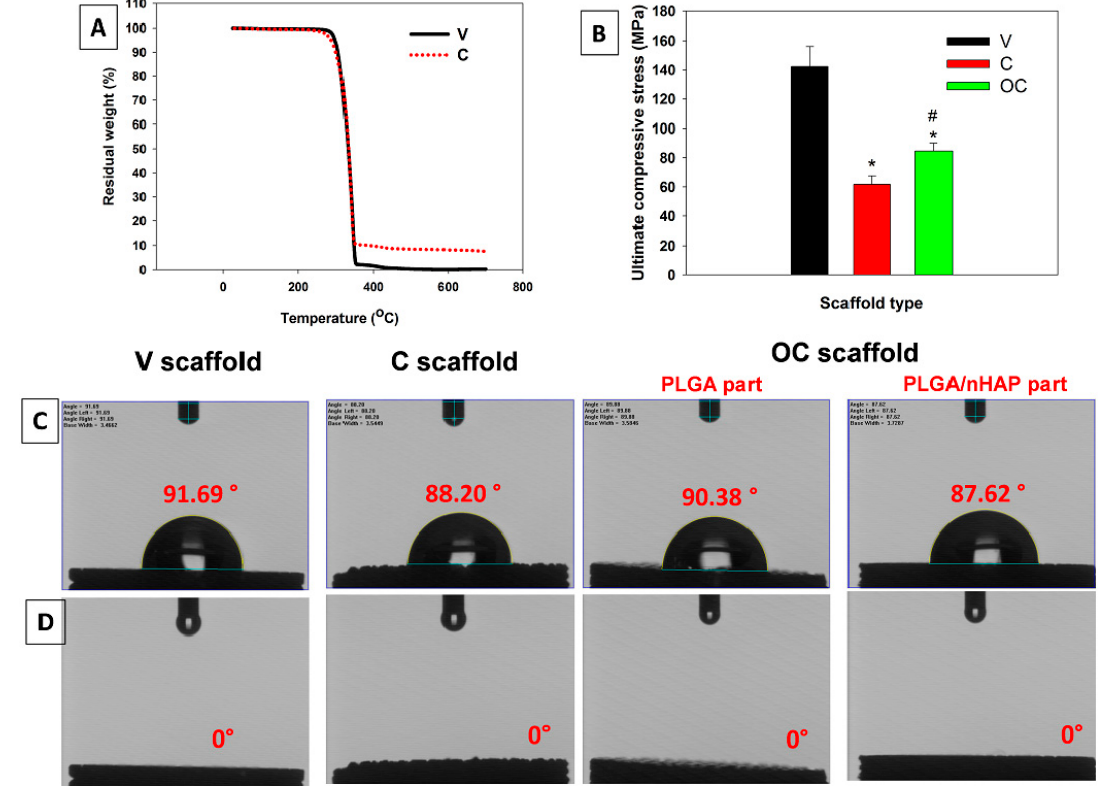
Figure 3. Thermal decomposition behavior ( A ) and mechanical testing ( B ) of V and C, and OC scaffolds. Surface hydrophilicity of V, C, and OC scaffolds by measuring water contact angles after 2 s ( C ) and 30 s ( D ); * p < 0.05 compared with V; # p < 0.05 compared with C.